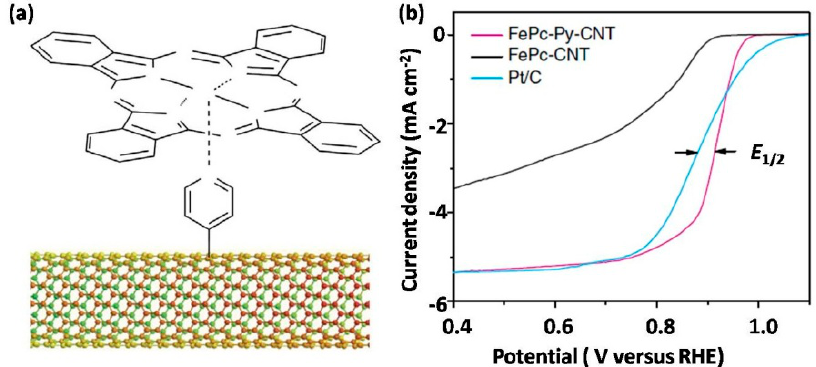
Figure 4. ( a ) Schematic diagram of the structure of FePc–Py–CNTs composite;